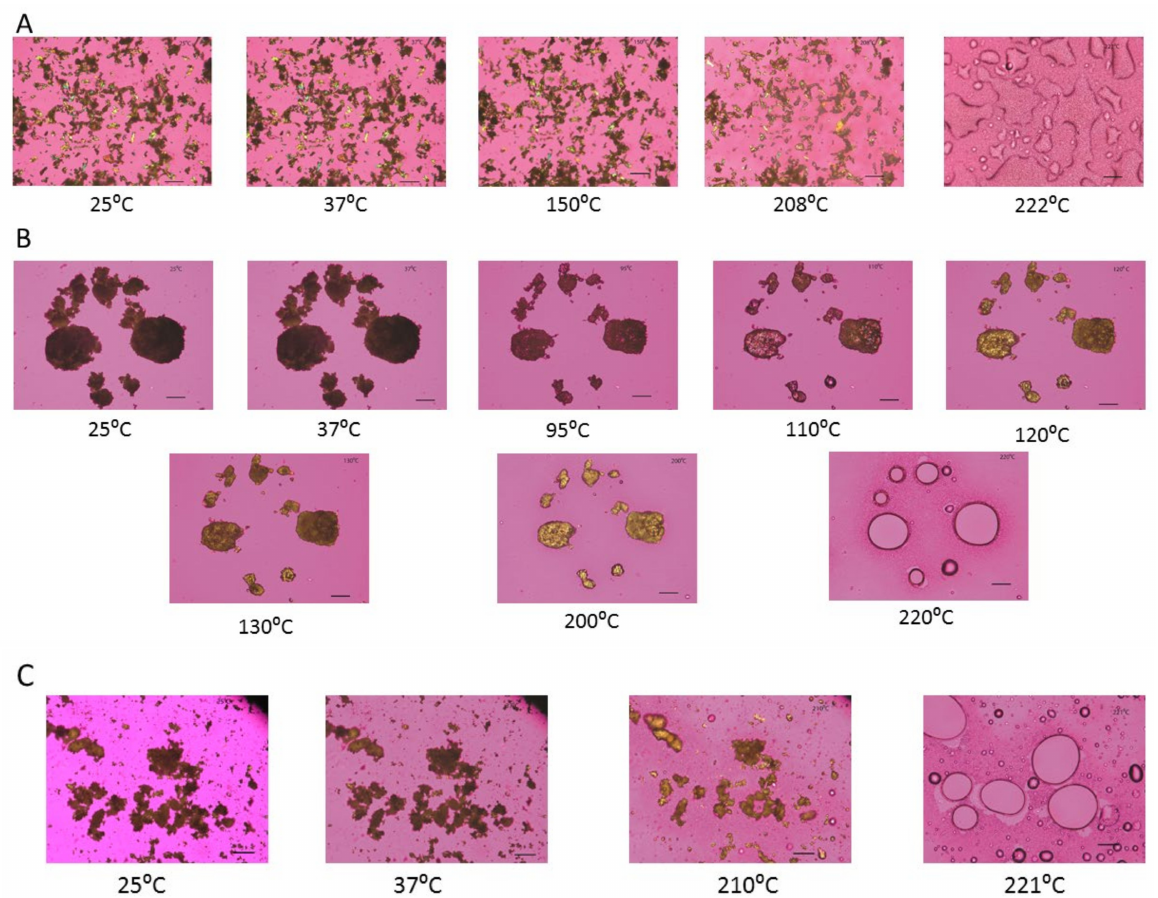
Figure 6. Representative HSM images of: ( A ). Raw FAS; ( B ). SD FAS 25% pump rate; and ( C ). SD FAS 100% pump rate. Scale bar in each image is 10 µ m.